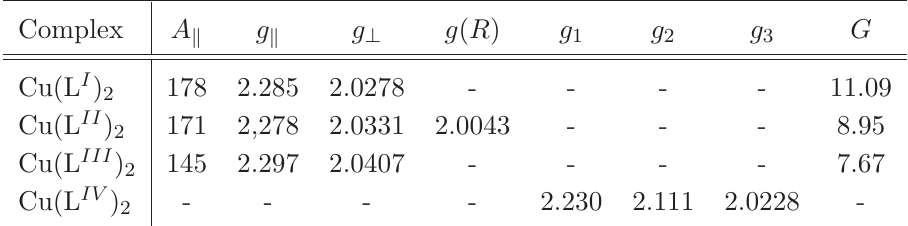
Table 2 ESR parameters of Cu (II)